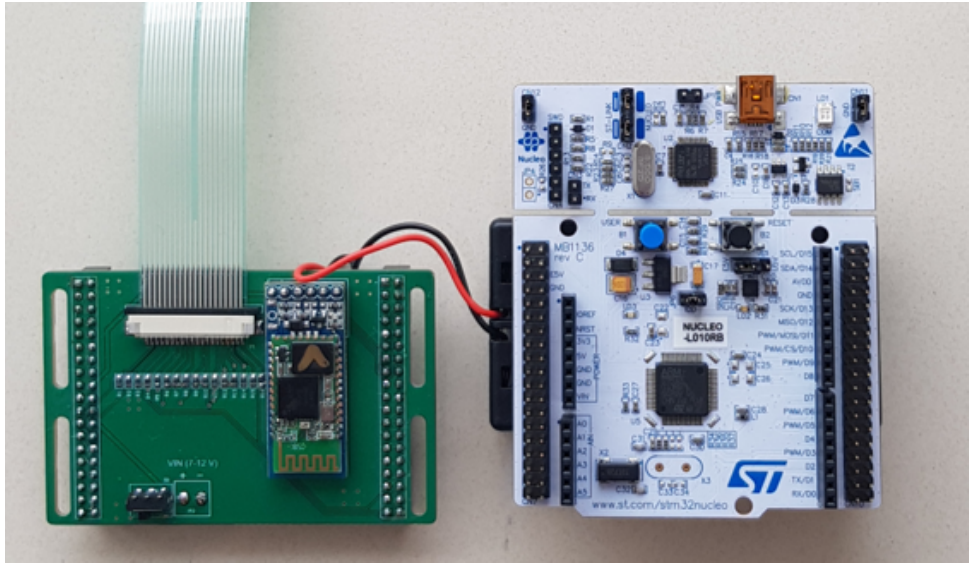
Figure 11. Nucleo L010RB with dedicated